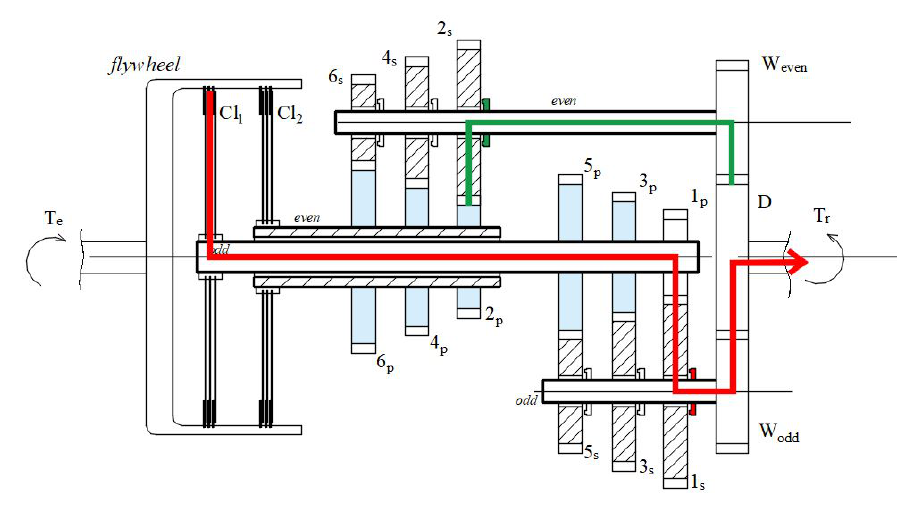
Figure 5. The DCT gear shifting transient: 1st gear running, 2nd gear pre-selected.